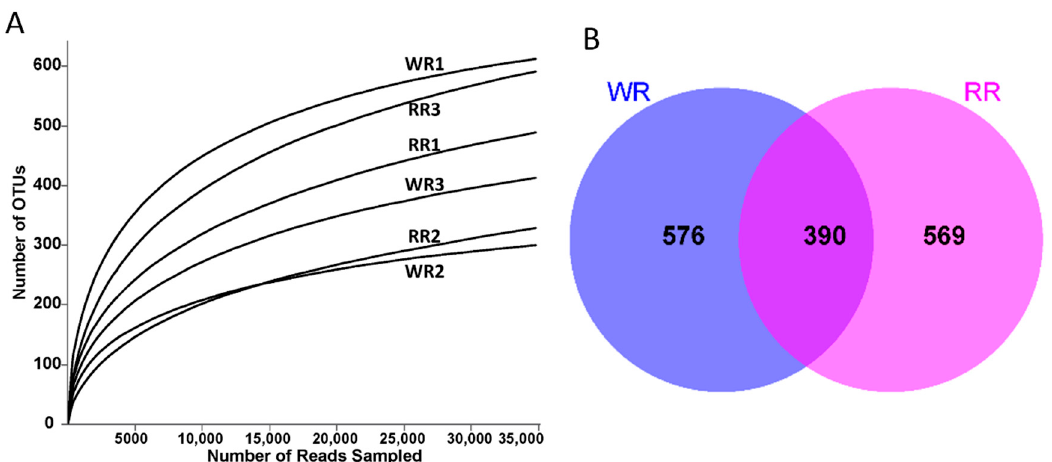
Figure 1. ( A ). Rarefaction curves of rhizospheric soil samples from wild and reintroduced M. sinica at a 97% similarity threshold; ( B ). OUT-Venn graph of rhizospheric soil samples from wild and reintroduced M. sinica (WR1, WR2, and WR3 represent the three replicates of rhizospheric soil samples from wild plants (WR); RR1, RR2, and RR3 represent the three replicates of rhizospheric soil samples from reintroduced plants (RR)).